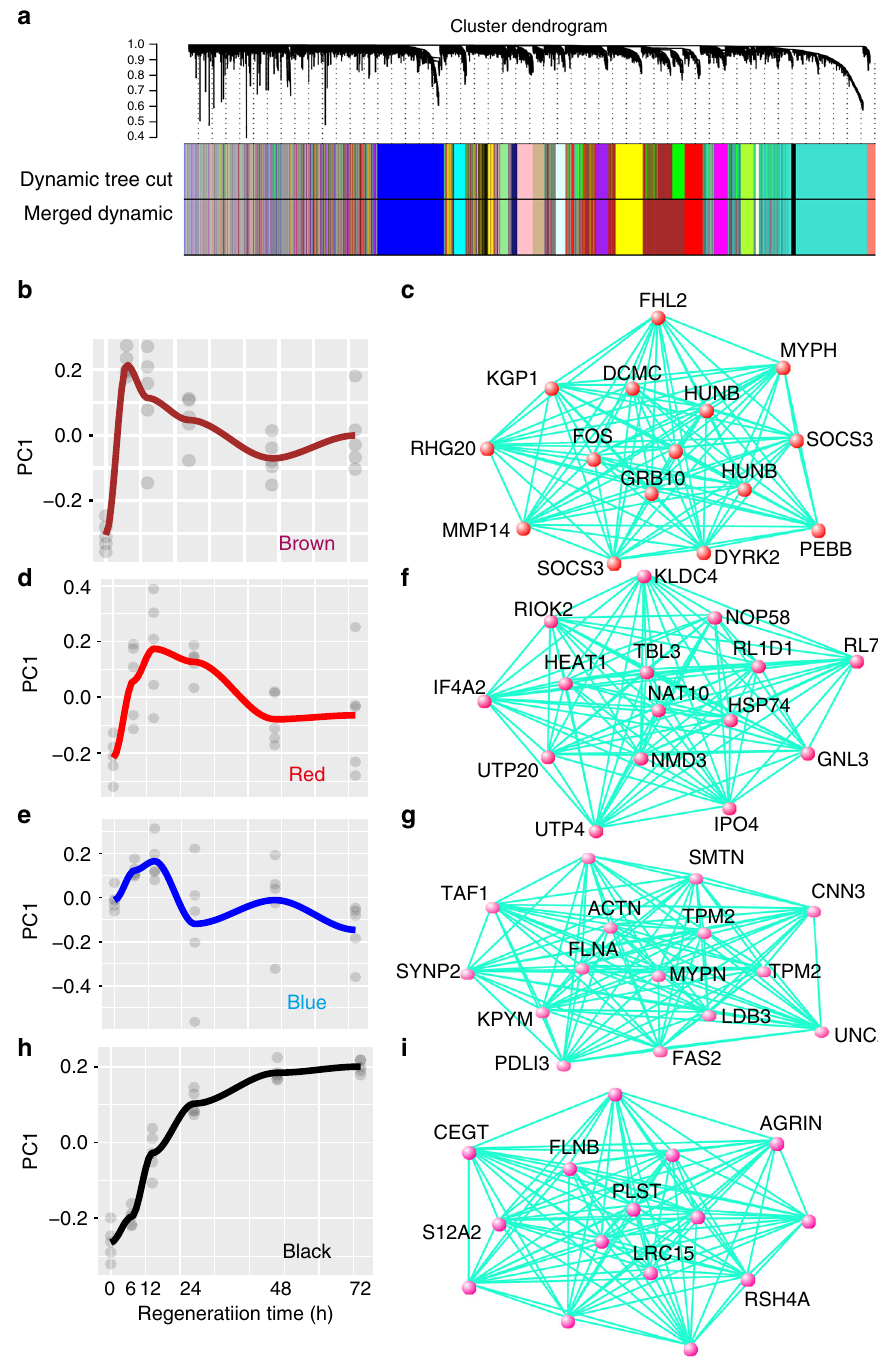
Fig. 5 Coexpression network analysis in regeneration. a Network analysis dendrogram showing modules based on the coexpression topological overlap of genes throughout regeneration. Colored bars below give information on module membership. b The expression trajectory of brown module throughtout regeneration. c Top15 driver genes of brown module. d The expression trajectory of red module throughtout regeneration. e The expression trajectory of blue module throughtout regeneration. f Top15 driver genes of the red module. g Top15 driver genes of the blue module. h The expression trajectory of black module throughtout regeneration. i Top15 driver genes of the black module. For b , d , e and h the fi t line represented locally weighted scatterplot smoothing. X -axis represented regenerative time points and y -axis represented the module eigengene. For c , f , g and i , top15 drivers were obtained by WGCNA network connection algorithm with the threshold of 0.03, and the drivers without symbols were unde fi ned protein-coding genes. Those drivers with identical symbols were annotated as